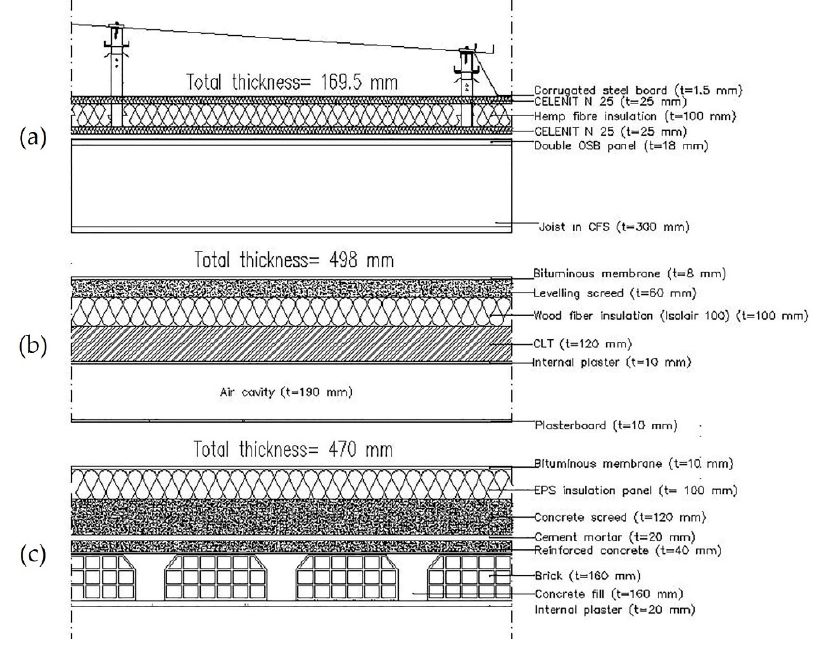
Figure 9. Roof configurations: ( a ) CFS; ( b ) CLT; ( c ) traditional. Table 2. Total thickness and thermal transmittance values.